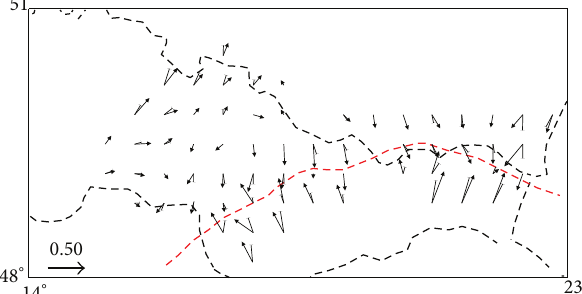
Figure 5: The real part of GDS data (arrows) and the calculated data (arrows without arrowhead) showing the fitness of the model response to the observed data. In blocks with only data plotted, both observed and calculated induction arrows coincide although their magnitude might be different.